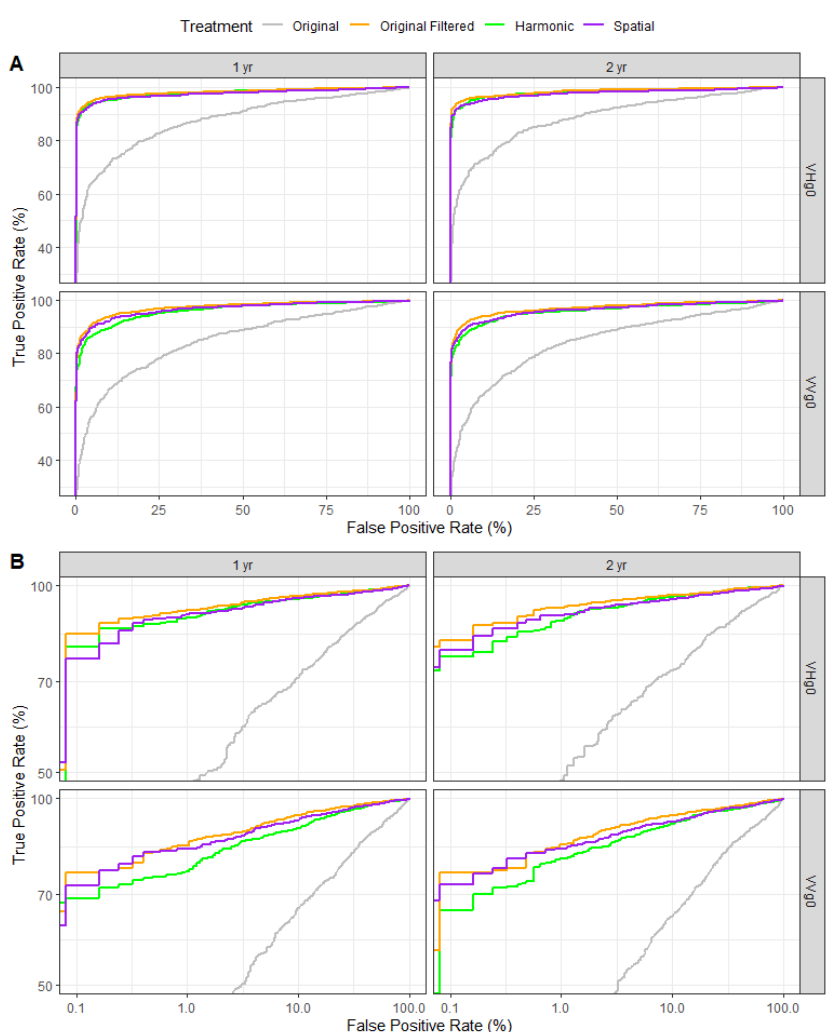
Figure 13. ROC curves associated to the adaptive linear thresholding detection procedure. ( A ) Using a linear scale. ( B ) Log-scaled detail. We also considered the best results of the ALT method given an optimum level of TNR. Based on field experience, we fixed this level as 99.5%, which is equivalent to a rate of false positives of 0.5% (Table 7).